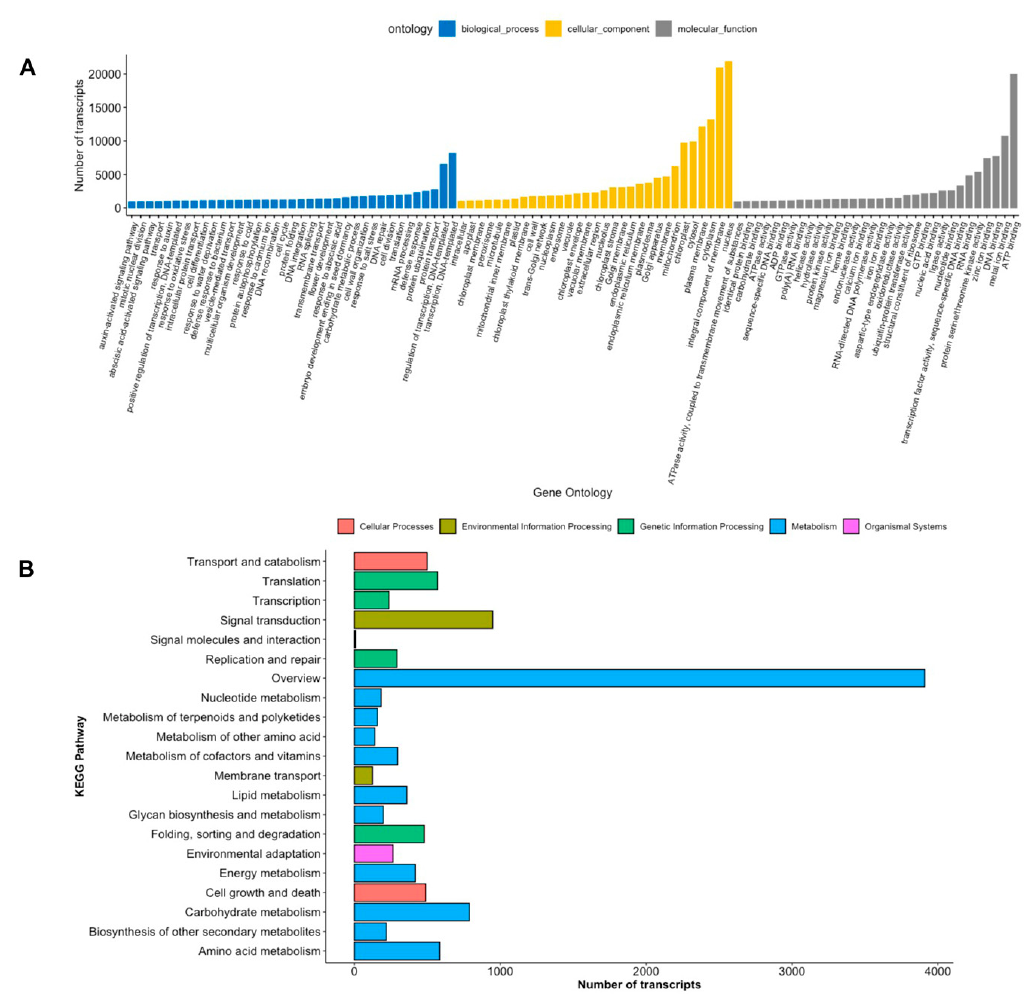
Figure 3. Gene ontology and KEGG pathways annotation. ( A ) Number of transcripts by GO category. ( B ) Number of transcripts by KEGG pathways. Different colors represent the GO category and KEGG